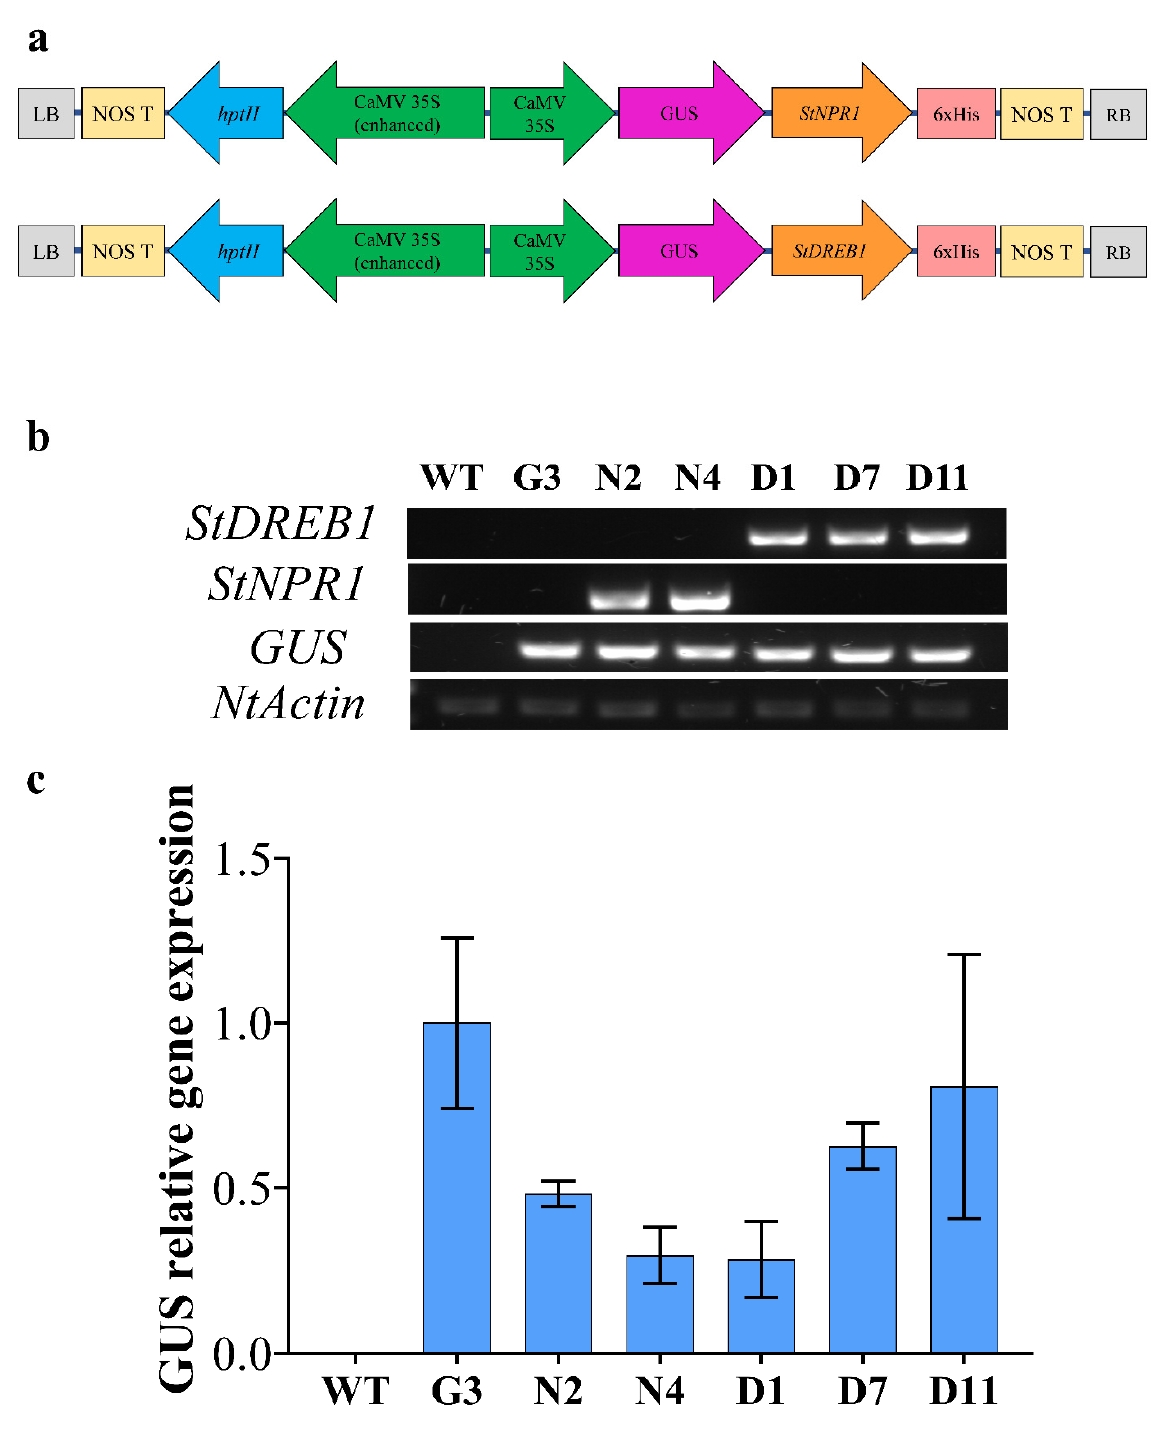
Figure 4. Overexpression of tomato StNPR1 and StDREB genes in tobacco. ( a ) Schematic map of genetic constructs expressing GUS-StNPR1 - and GUS-StDREB1 chimeric proteins under the control of the CaMV35S promoter. ( b ) Confirmation of transgenes in the genomic DNA by semi-quantitative PCR amplification of GUS , StNPR1 and StDREB1 transcripts in WT, and transgenic lines of GUS only (G3) StNPR1 (N2 and N4) and StDREB1 (D1, D7 and D1). Tobacco Nt-Actin was used as an internal gene control. ( c ) Relative GUS expression in the transgenic lines using qRT-PCR. No significant differences were observed among the transgenic lines at p ≤ 0.05 according to Tukey test.